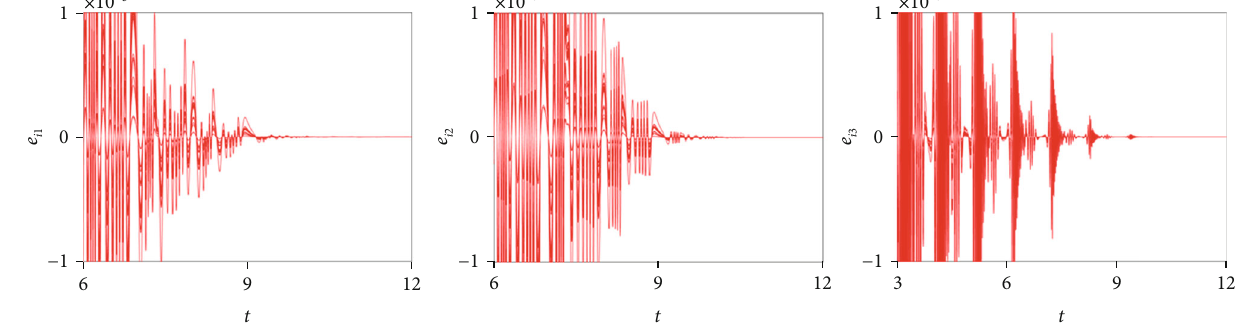
ð t Þ with system evolution. i